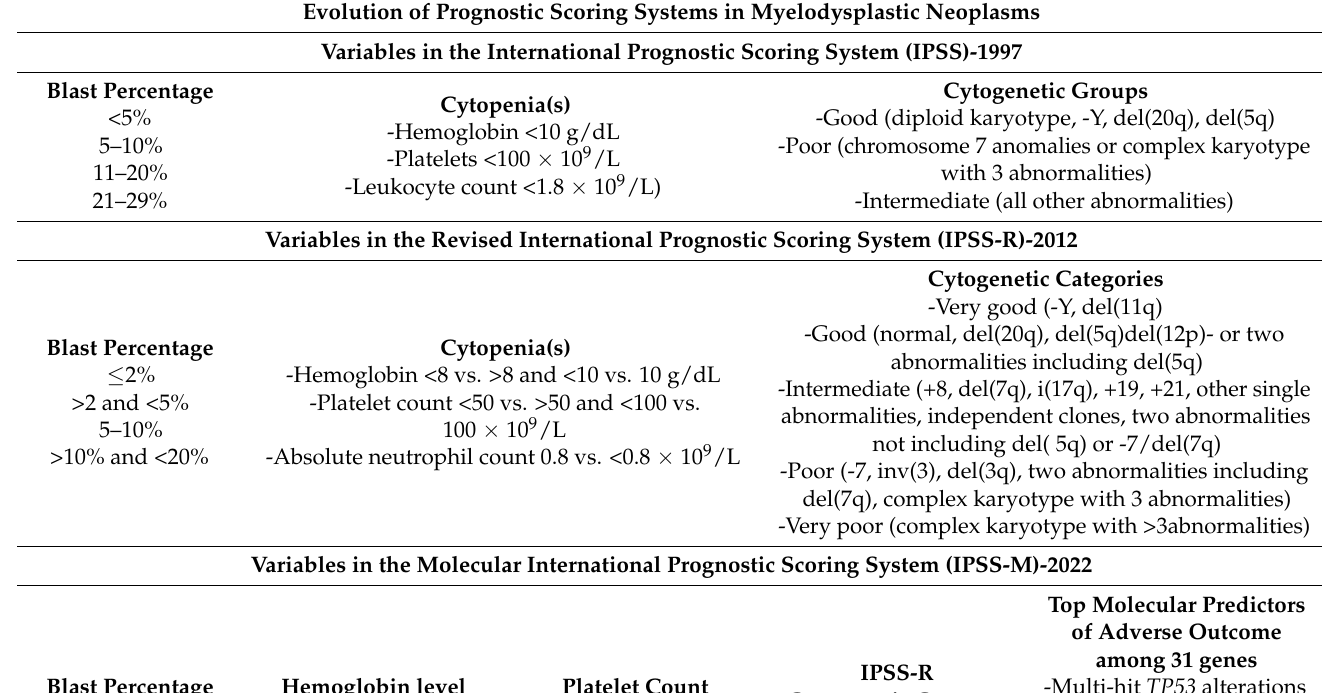
Table 3. Evolution of Prognostic Scoring Systems in Myelodysplastic Neoplasms. Evolution of Prognostic Scoring Systems in Myelodysplastic